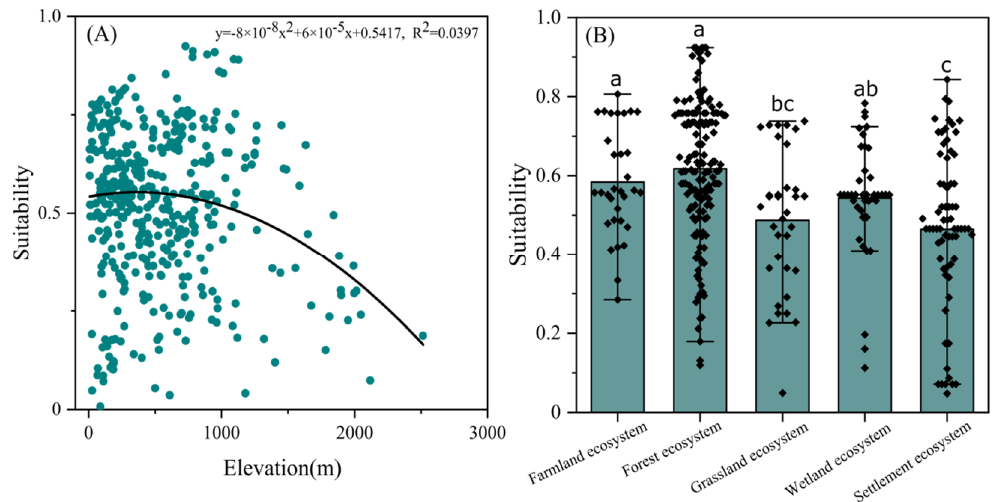
Figure 4. Effects of elevation ( A ) and ecosystem type ( B ) on habitat suitability of N. chinensis . Small letters indicated significant differences among five ecosystem types (farmland ecosystem, forest ecosystem, grassland ecosystem, wetland ecosystem, and settlement ecosystem) at p < 0.05 according to one-way ANOVA.